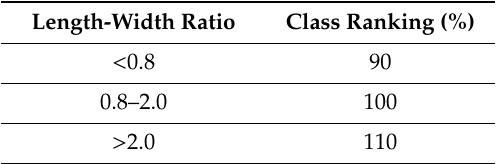
Table 2. Categorisation by time e ffi ciency of the length-width ratio in Italian